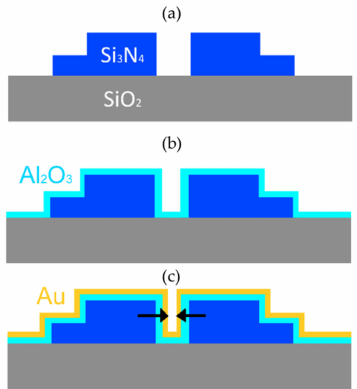
Figure 2. Fabrication of a nanoplasmonic slot waveguide. ( a ) Fabrication of the Si 3 N 4 slot waveguides. ( b ) Atomic layer deposition of Al 2 O 3 . ( c ) Gold deposition. The arrows mark the gap width of the nanoplasmonic slot